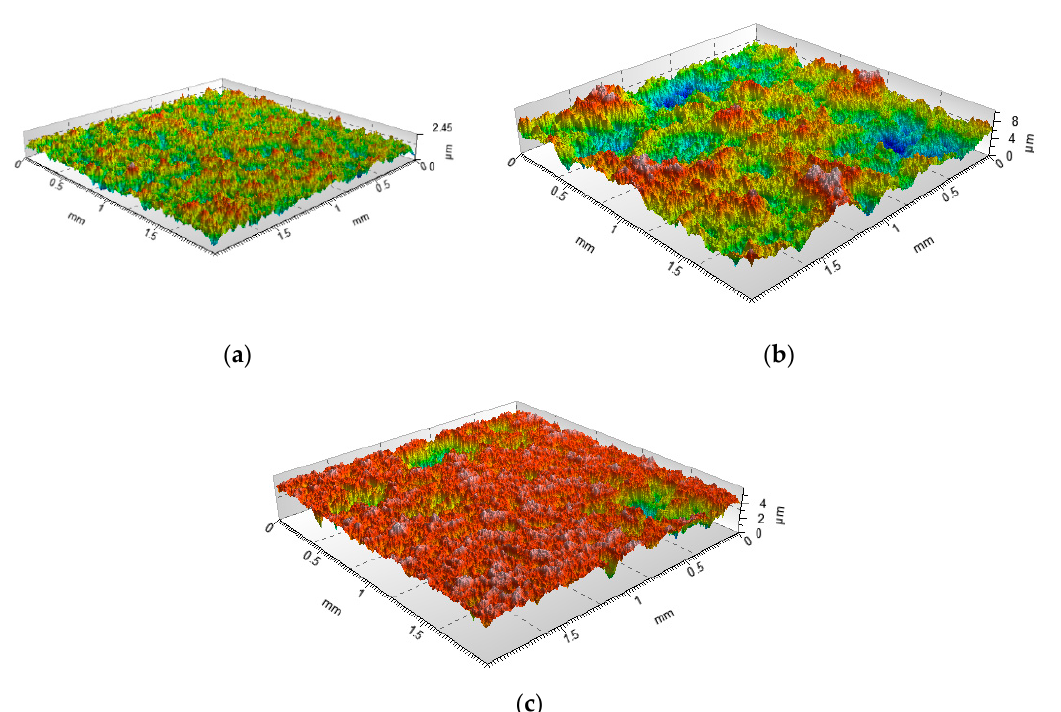
Figure 3. Example of generation of two-process surface topography: the plateau surface: Sq = 0.3 µm, CL = 20 µm ( a ), the valley surface: Sq = 1.7 µm, CL = 150 µm ( b ), two-process surface: Spq = 0.3 µm, Svq = 1.7 µm, Smq = 72.7% ( c ), Sq is the rms. height, CL is the correlation length.